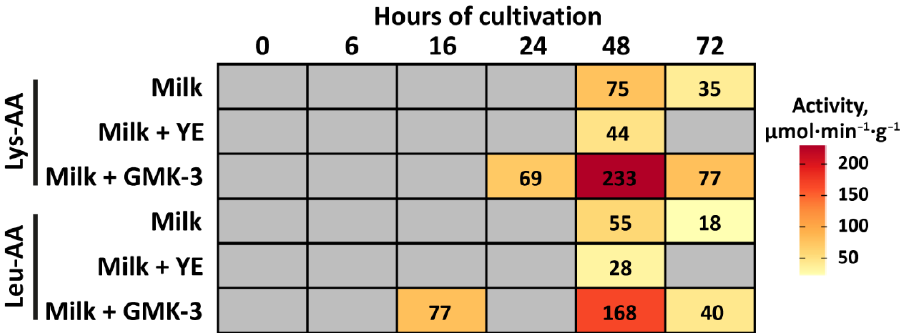
Figure 4. Lys-AA and Leu-AA of B. longum MC-42 during fermentation on different media: Milk —skim milk; Milk + YE —skim milk with addition of yeast extract, and Milk + GMK-3 —skim milk with the addition of a hydrolysate containing GMK-3 supplementation. The aminopeptidase activities are expressed as μ mol of p -NA released by aminopeptidase per minute and per gram of protein. The data are represented with a color-coded system where the highest value is shown in red and the lowest—in yellow.